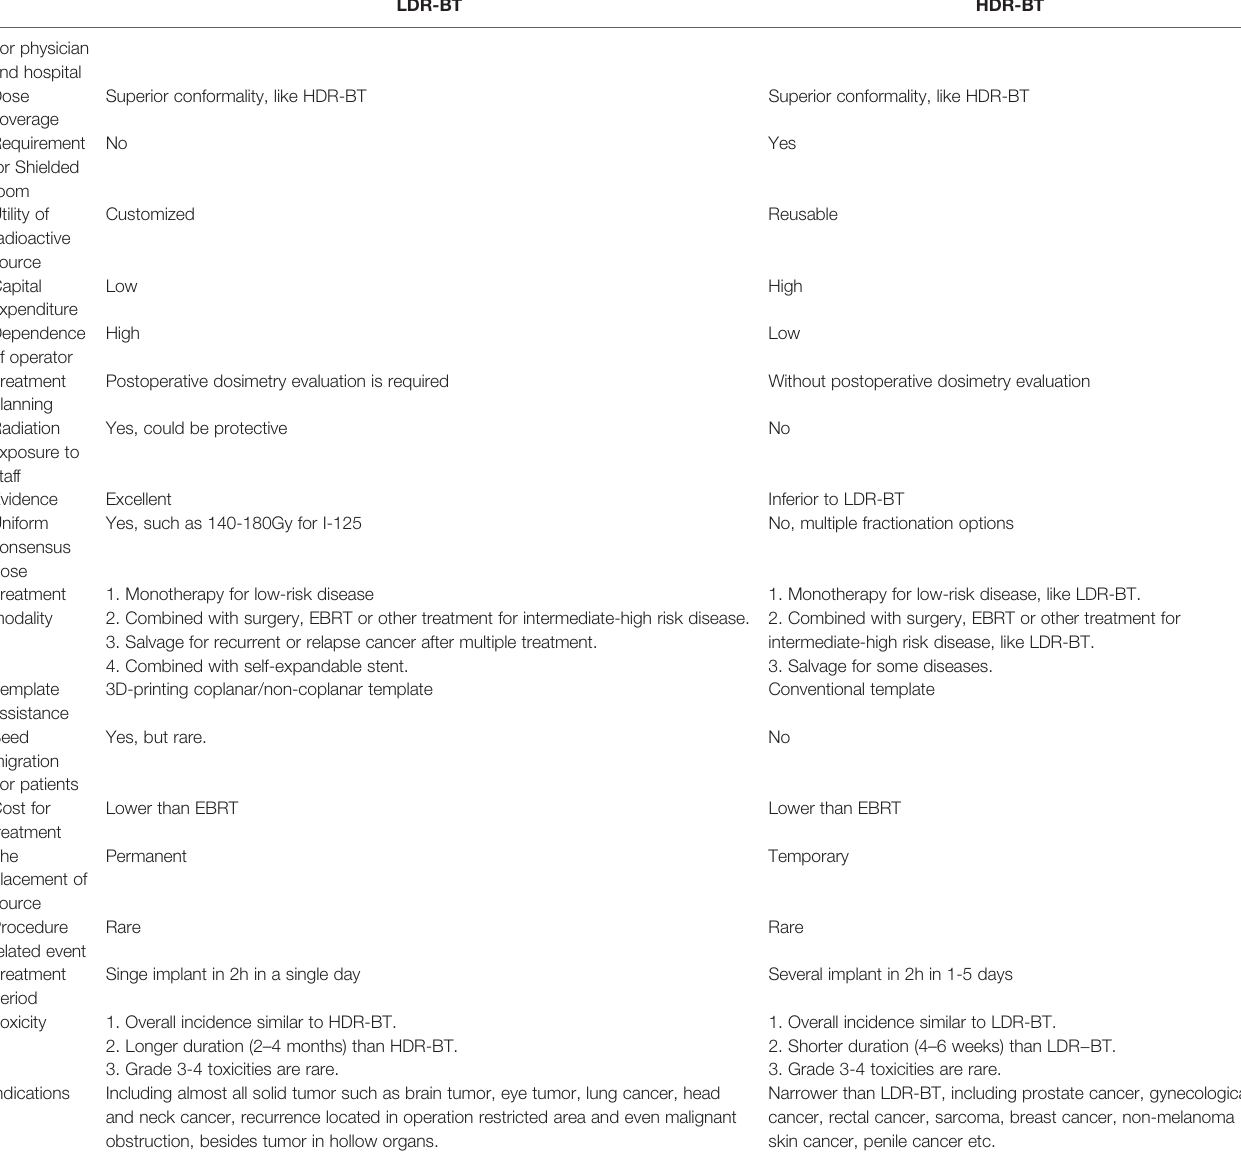
TABLE 1 | Overview of the applications of mesenchymal stromal cell-derived extracellular vesicles (MSC-EVs) in clinical studies.